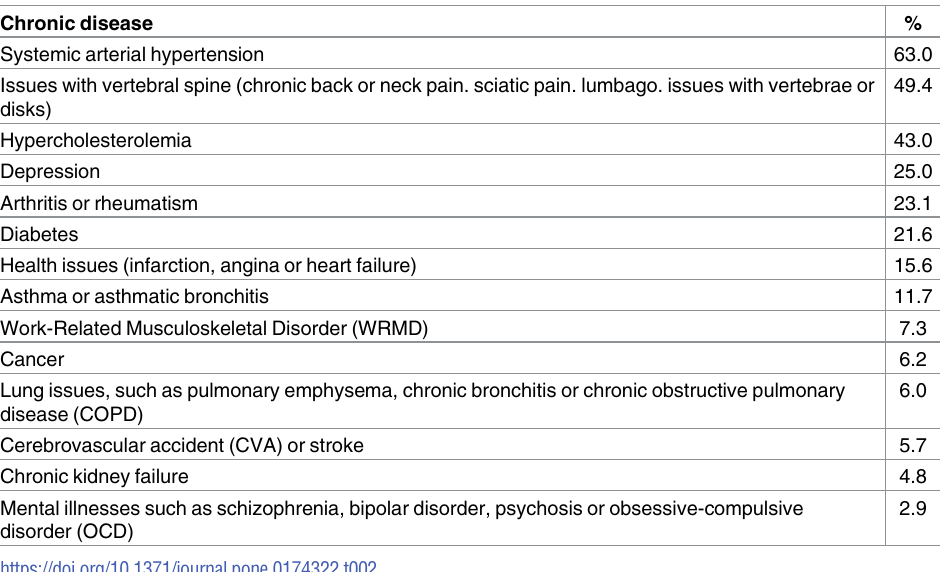
Table 2. Proportion(%) of chronic diseasesin the group of individuals with multimorbidity—NHS, Brazil.